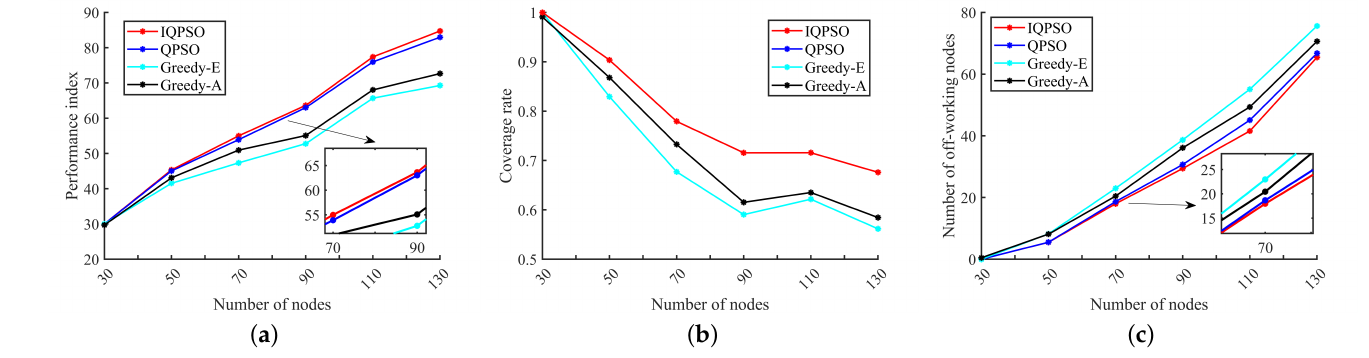
Figure 4. Effect of different network scales. ( a ) Performance index. ( b ) Coverage rate. ( c ) Number of off-working nodes.